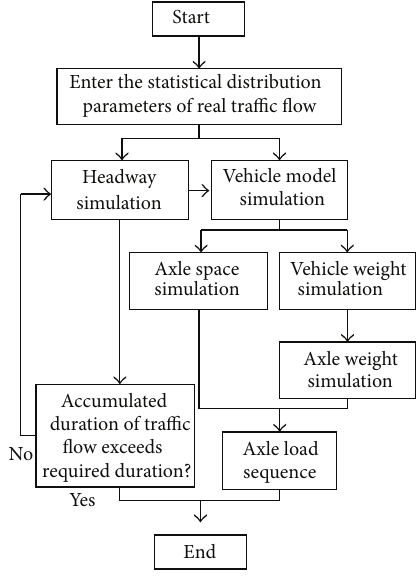
Figure 11: Flowchart of random traffic flow simulation program.